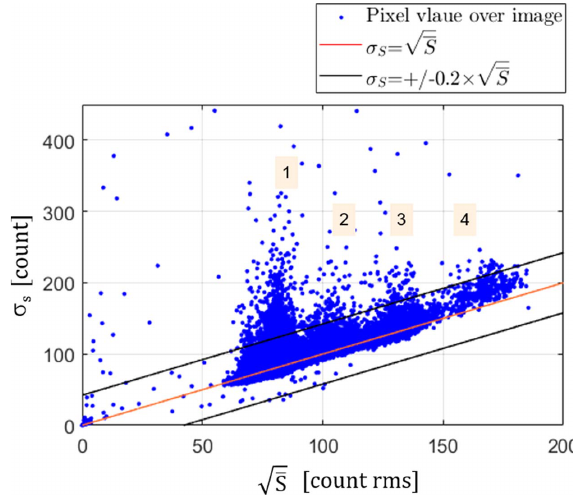
Figure 9 Standard deviation of all CirPAD pixels (averaged over 400 images) versus its mean intensity. The images were acquired with SLOW calibration and a counting time of 120 s, with an average of 6000 counts per pixel. Four groups of pixels are highlighted: ( 1 ) the largest number of pixels over the image; ( 2 ) the so-called double pixels; ( 3 )/( 4 ) pixels close to the guard ring. The Poisson distribution (cid:4) red line and two black lines at the 20% limit that determines the acceptance levels.